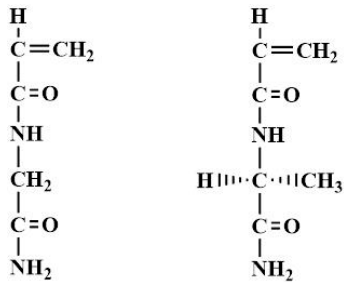
Figure 1. Chemical formula of N -acryloyl glycinamide (NAGA) ( left ) and N -acryloyl L -alaninamide chiral analog (NA L ALA) ( right ).